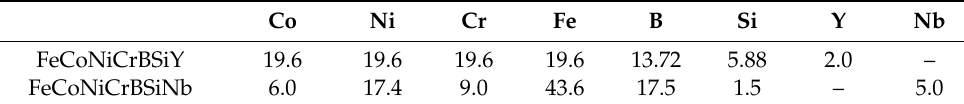
Table 1. Nominal chemical composition of the FeCoNiCrBSiY and FeCoNiCrBSiNb powders (at.%).